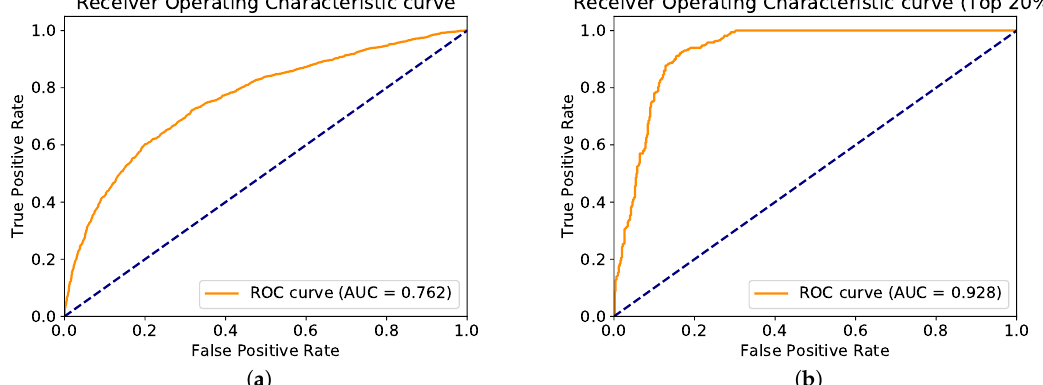
Figure 2. Receiver Operating Characteristic (ROC) curves for the car classification model for ( a ) all cars sampled from the 10 municipalities (AUC: 0.762) and ( b ) for the top 20% of the cars (AUC: 0.928). AUC: area under the